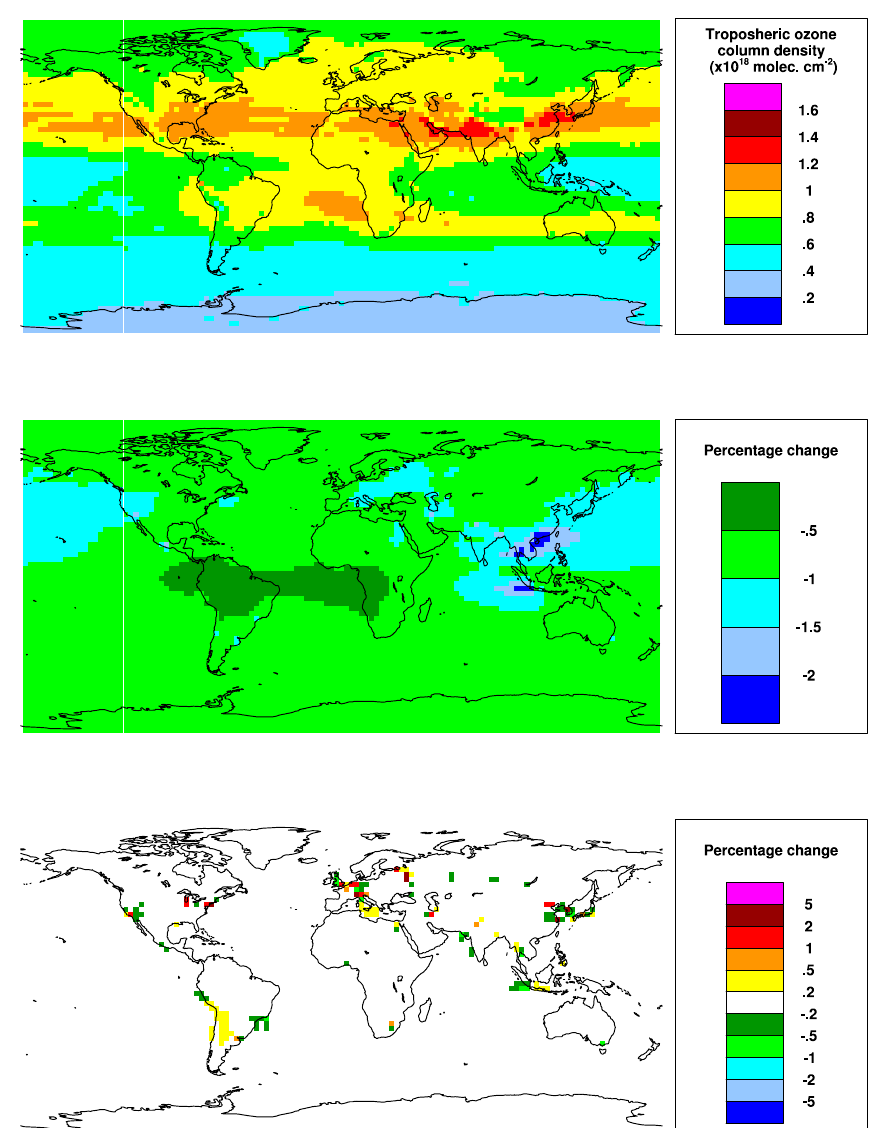
Fig. 5. Top panel: tropospheric ozone column density ( × 10 18 moleculescm − 2 ) from the 2005 base model run (1 × 10 18 moleculescm − 2 is approximately 37 Dobson Units). Middle panel: percentage change in tropospheric ozone column density from the 2005 base model run when emissions from megacities are masked. Bottom panel: percentage change in the surface ozone mixing ratio in the RCP-8.5 simulation for 2005 when 25% of the megacity emissions are redistributed throughout their host countries.